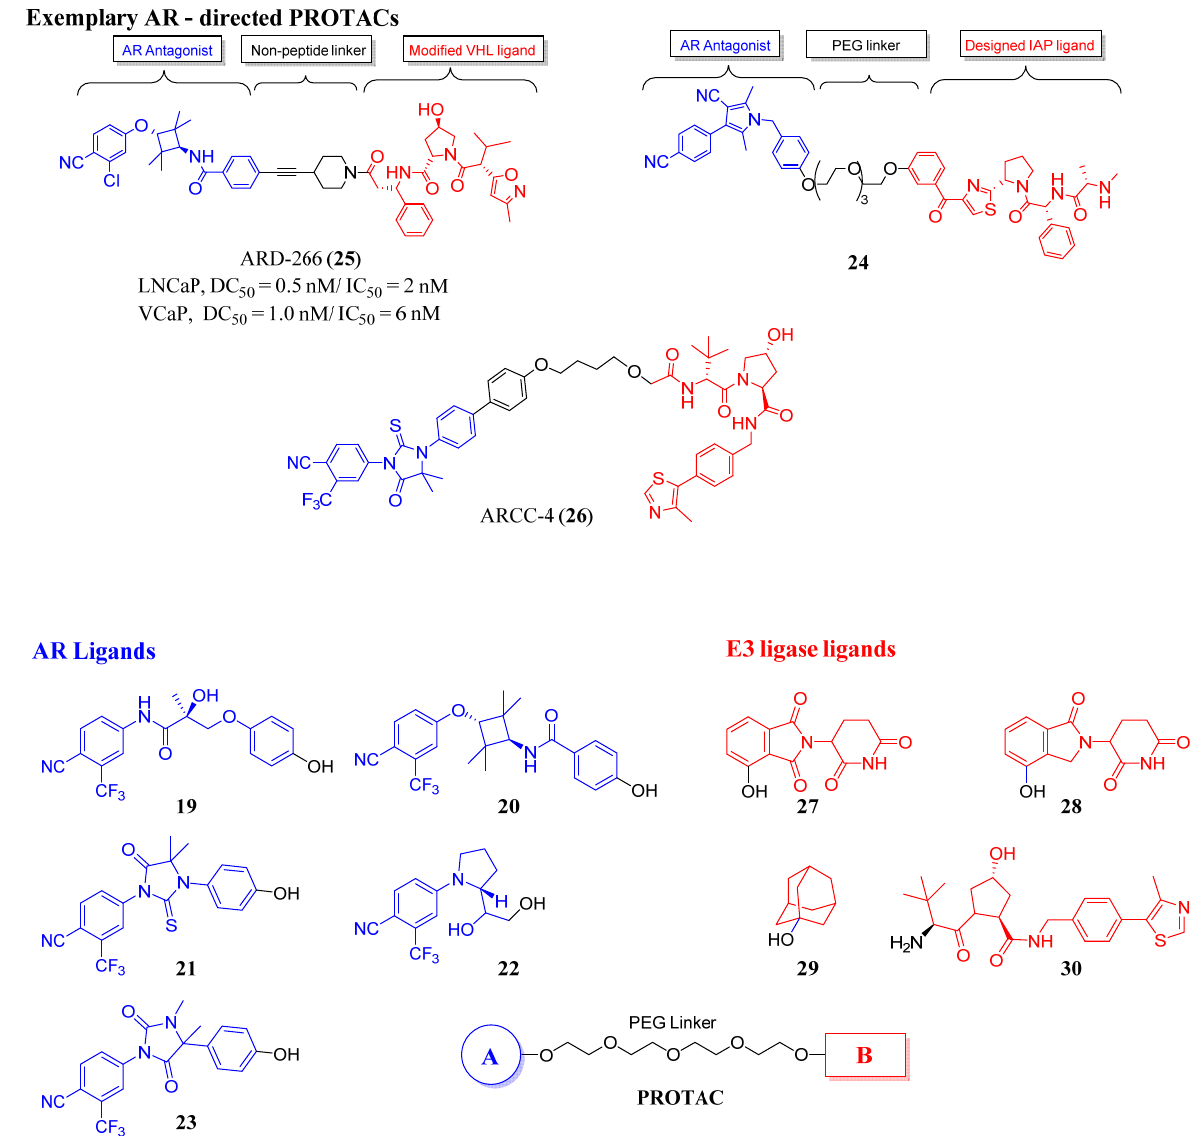
Figure 4. Exemplary AR-directed PROTACs and examples of AR ligands and E3 ligase ligands [39,40–44].